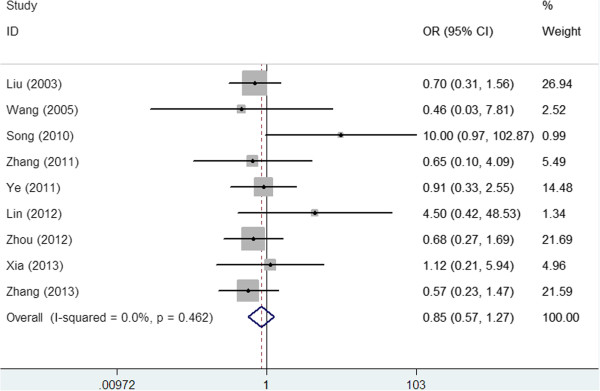
Forest plots of meta-analysis ofnonunion rate. Closed reduction internal fixation vs. open reduction internal fixation.